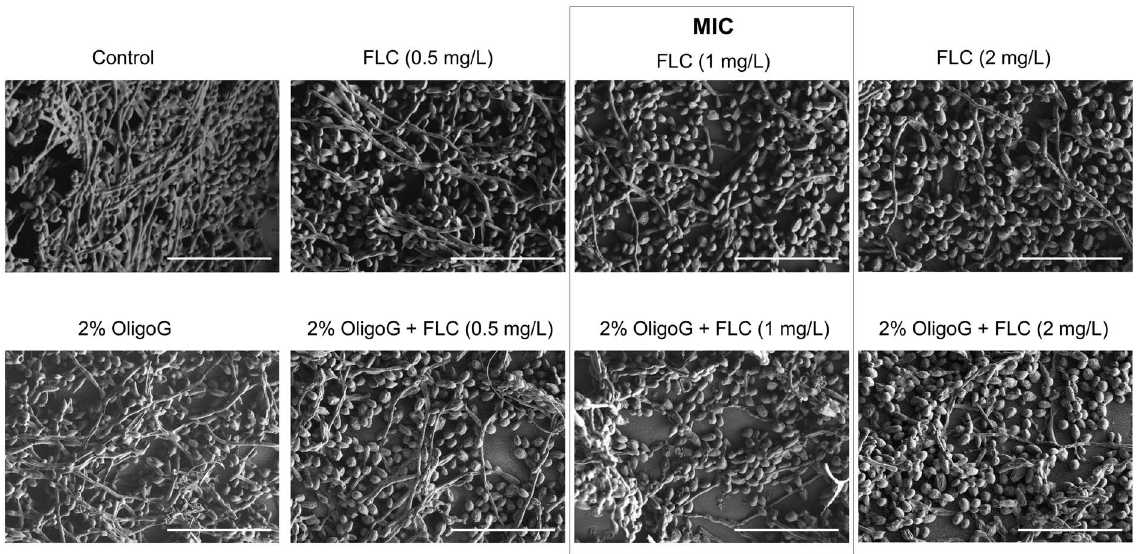
Figure 5. AFM imaging of Candidatropicalis 519468 grown on polystyrene with/without 2% OligoG and/or fluconazole (FLC). FLC was used at 1 mg/L (equivalent to the MIC) with more rounded cells (post OligoG treatment), more flattened cells (post fluconazole treatment) and both flattened, and ‘‘wrinkled’’ cells (post combination treatment) apparent. Z scale of 7.5 m m. Scale bar is 15 m m.